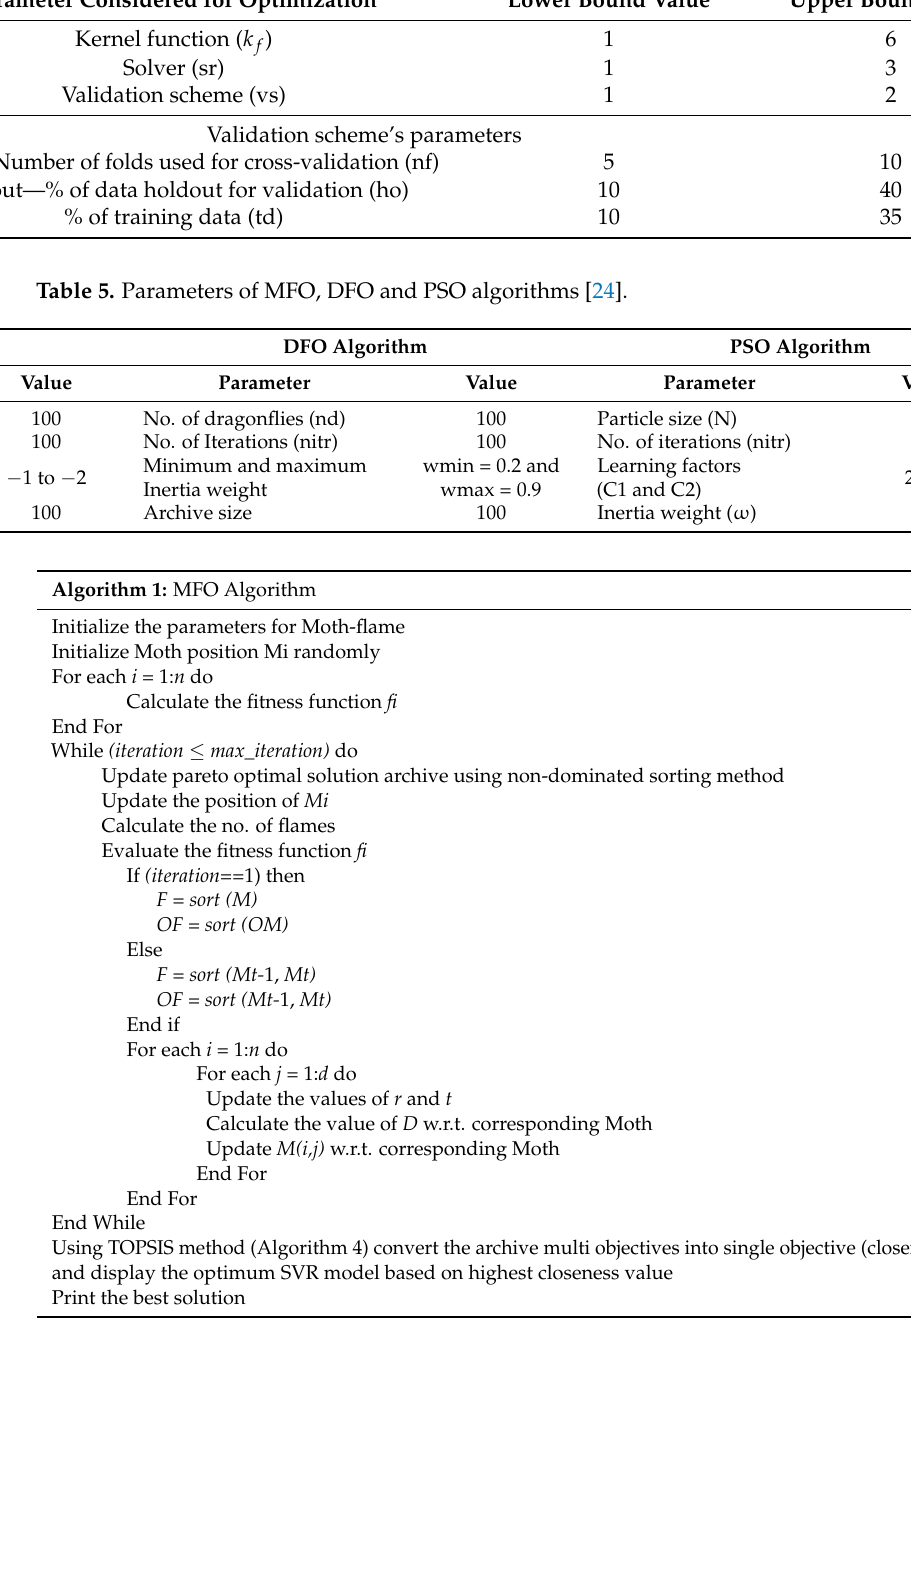
Table 4. Lower and upper bound value of SVR parameters.